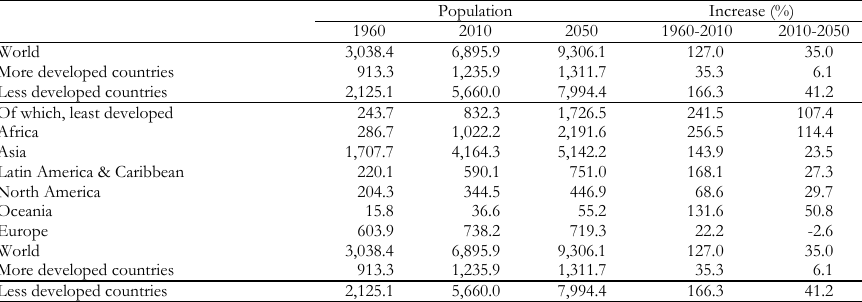
World population by economic development and major area, 1960-2050 (thousands)